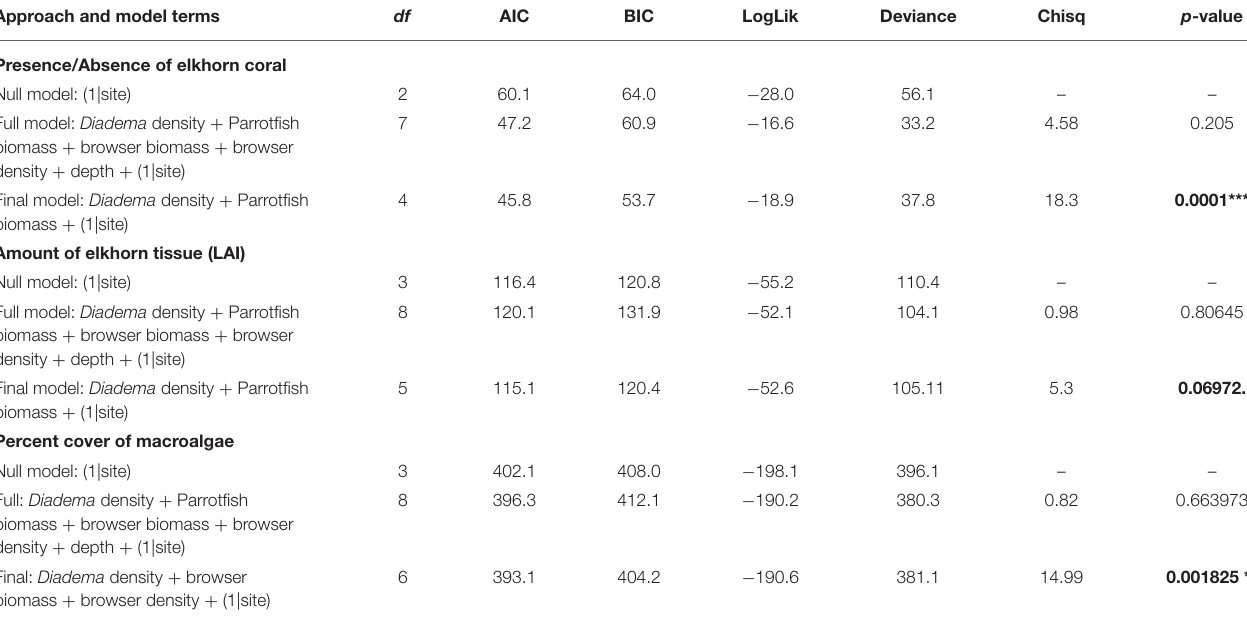
TABLE 4 | Summary of model comparisons. Approach and model terms BIC Deviance